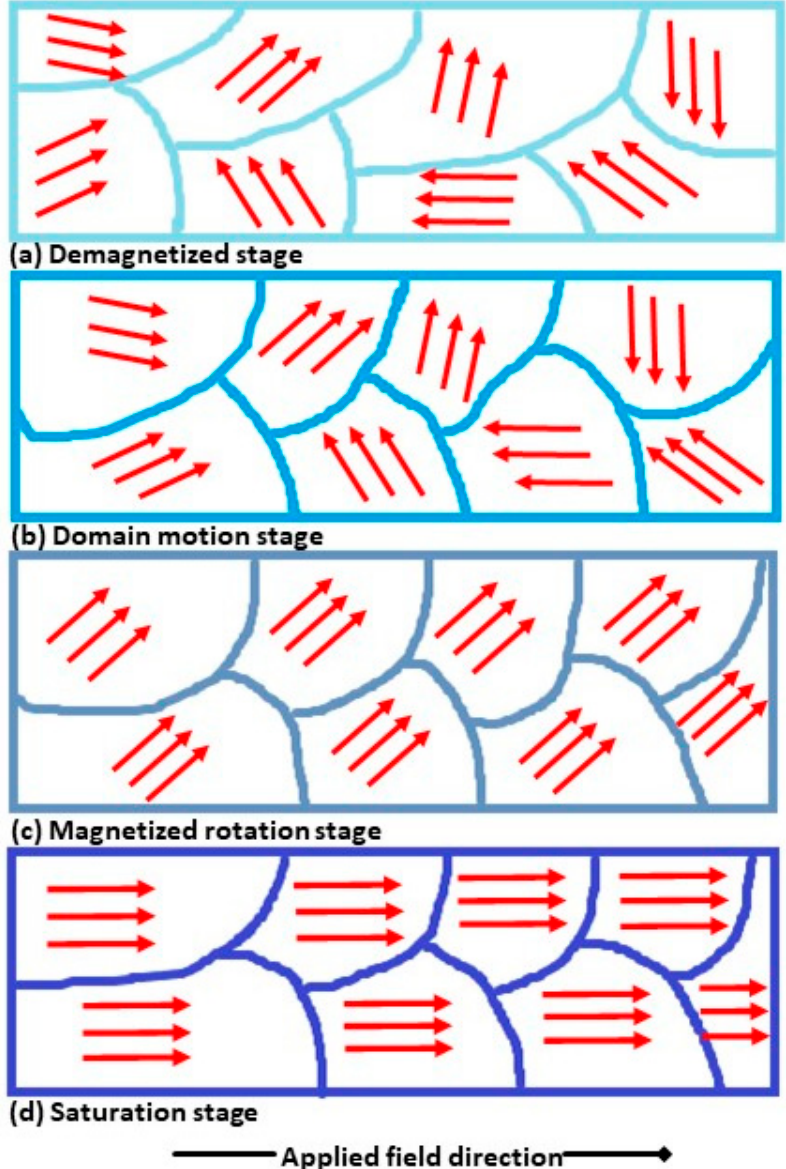
Figure 2. Schematic representation the describing the mechanism for the magnetization: ( a ) demagnetized stage, ( b ) low strain region—domain wall motion stage, ( c ) rotation (closest to the applied field) stage, and ( d ) saturation (alignment with applied field) stage.